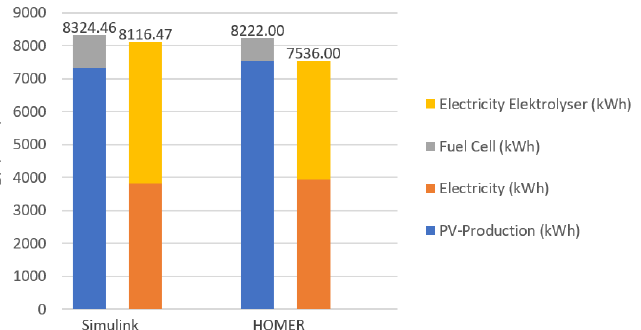
Figure 15. Comparison of the energy produced and consumed by Simulink and HE (in kWh/a).